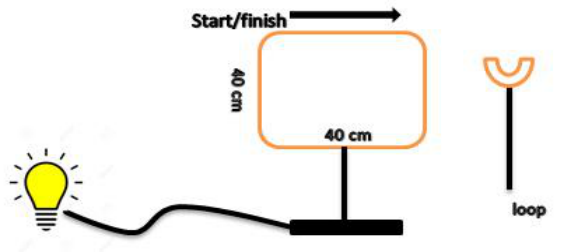
Figure 1. The apparatus for training the tracking task included a wire square trajectory which had 40 cm for each side and a light bulb that would turn on when the loop touched the wire. To accomplish one trial of the task, participants had to put the loop on the top and the left corner of the square and move the loop around the wire square to reach the start place again.